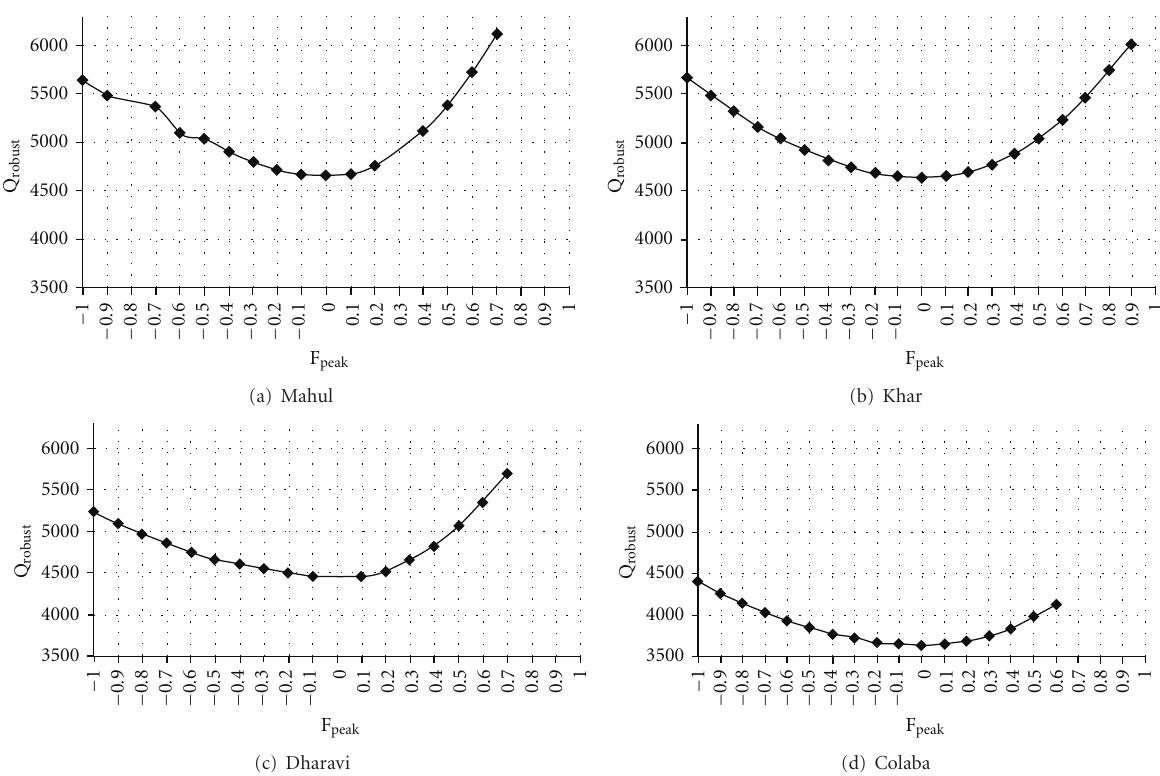
Figure 2: Position of original solution using di ff erent values of F peak for all